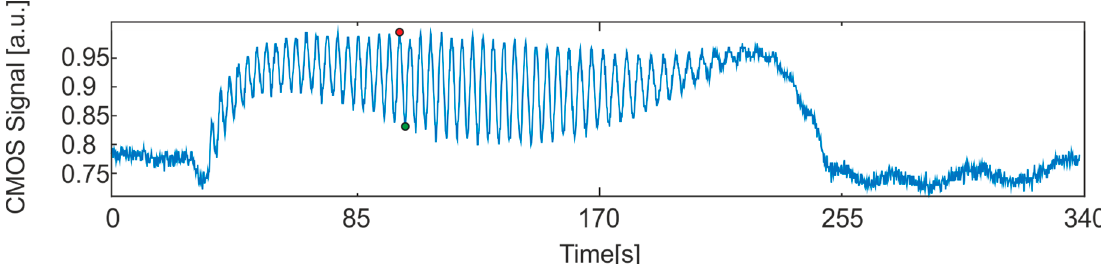
Figure 3. Unprocessed CMOS-signal taken from a single pixel as indicated in Figure 2. The green and orange dots correspond to the interference maximum and -minimum shown in Figure 2,